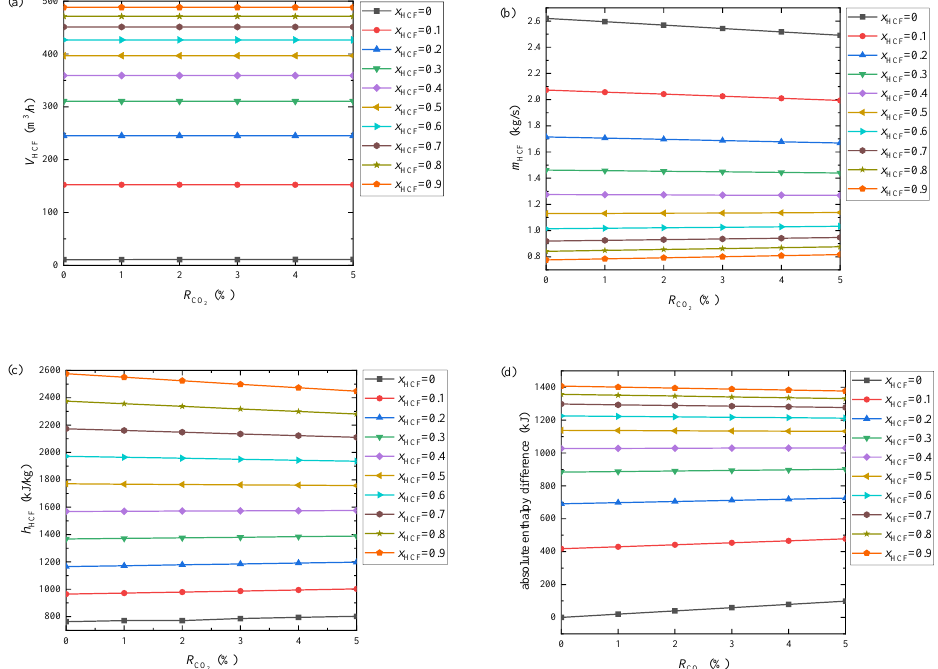
Figure 12. Variation curves of production capacity parameters of heat carrier with R CO2 under different steam quality: ( a ) volume flow rate, ( b ) mass flow rate, ( c ) enthalpy and ( d ) absolute enthalpy difference.